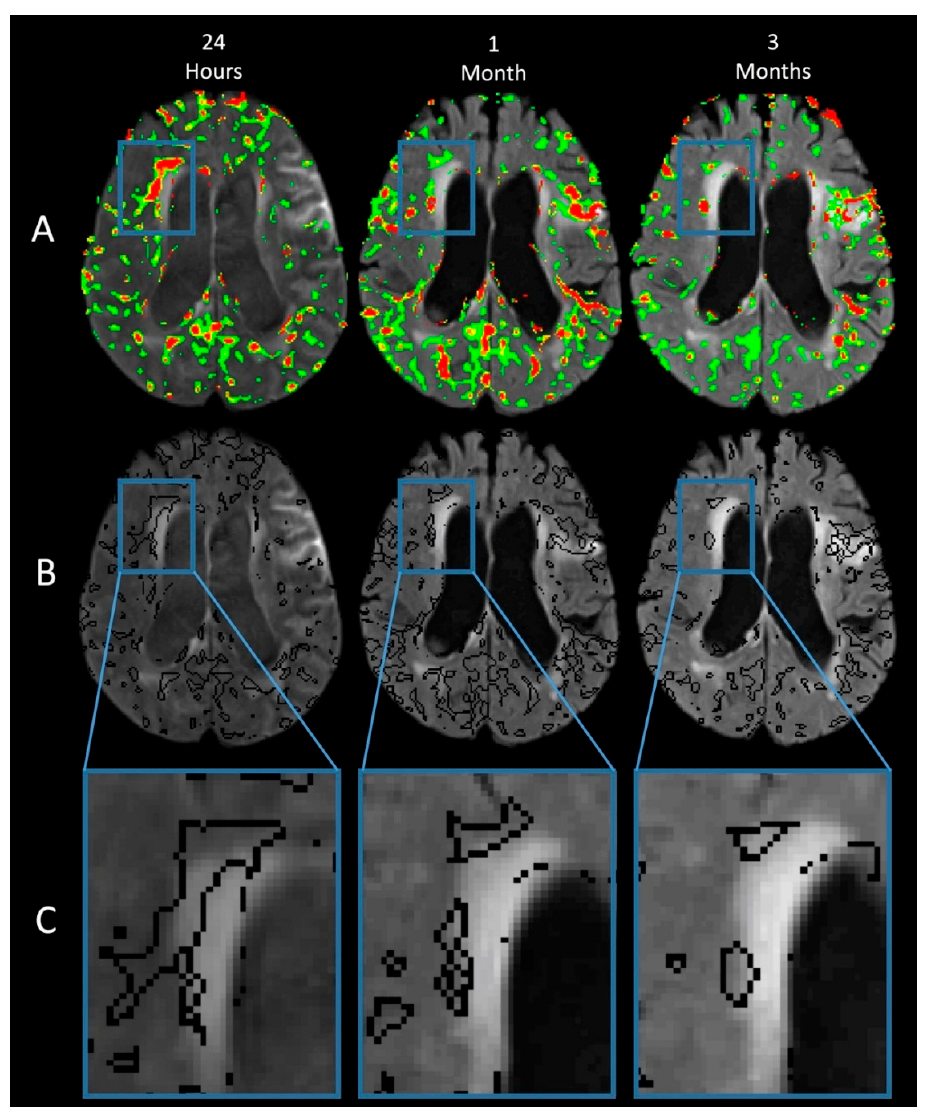
Figure 2. The same region of the brain is shown at three time points: column 1 is 24 hours after the stroke, column 2 is 30 days after the stroke, and column 3 is 90 days after the stroke. Row A shows the BBB permeability heatmap superimposed on the FLAIR scan at each time point. The amount of BBB disruption is color coded: green 0.5% to 0.8%, yellow 0.8% to 0.9%, orange 0.9% to 1%, and red >1%. Although the BBB disruption has reversed in the area of the acute stroke (see text for description in results section), there is prominent BBB disruption in the contralateral hemisphere as pointed out in the boxed region. Note that the BBB disruption in the boxed area, as well as diffusely throughout the brain, is most severe immediately after the stroke and although it decreases over time, it persists for months. Row B shows the same BBB disruption from row A, except that now it is outlined instead of color coded. This allows visualization of the white matter hyperintensities (WMH) on the FLAIR below the BBB disruption. Row C shows the boxed region from row B magnified for examination of the WMH. Note the pattern of BBB disruption, often involving the normal appearing white matter (NAWM) adjacent to the WMH. BBB disruption involving the NAWM persists out to 90 days.